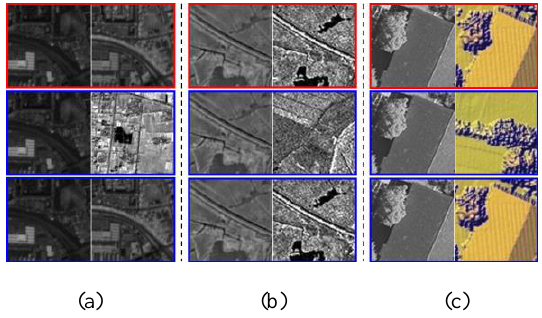
Figure 7. Examples of training sample. The samples from top to bottom in (a) are a pair of positive sample, a pair of RNS, and a